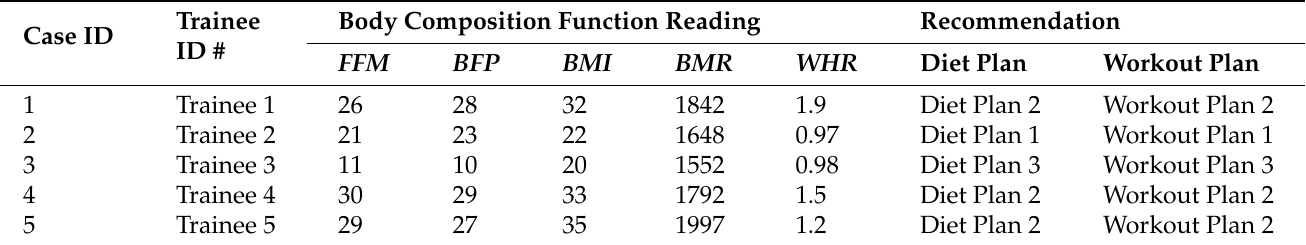
Table 9. Summary of the use case for different workout and diet plan recommendation based on the body composition function values.